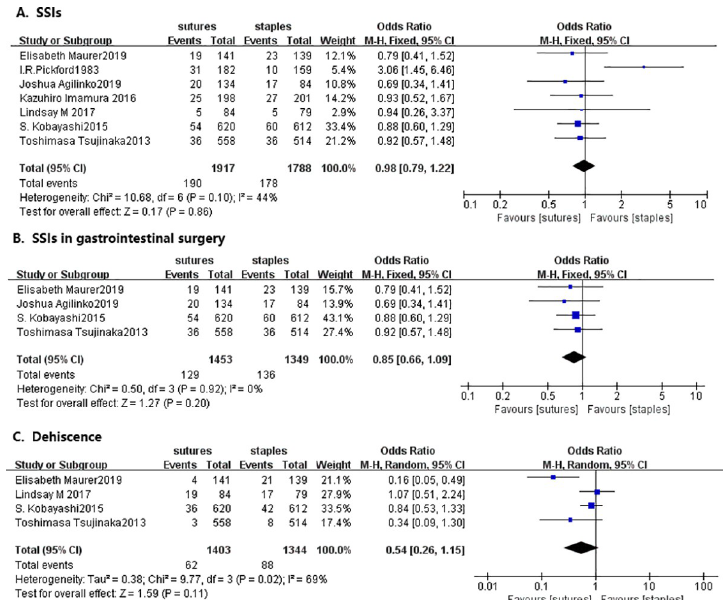
Fig 2. Forest plot of the pooled outcomes of (A) SSIs (B) SSIs in gastrointestinal surgery (C) Wound dehiscence in selected studies comparing staples to subcuticular suture for skin closure after abdominal surgery.